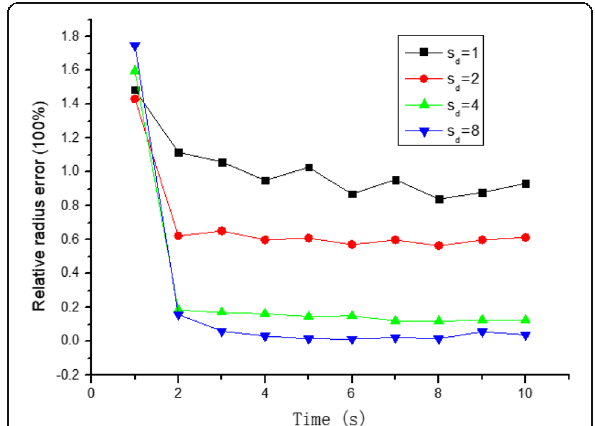
Fig. 4 Impact of anchor